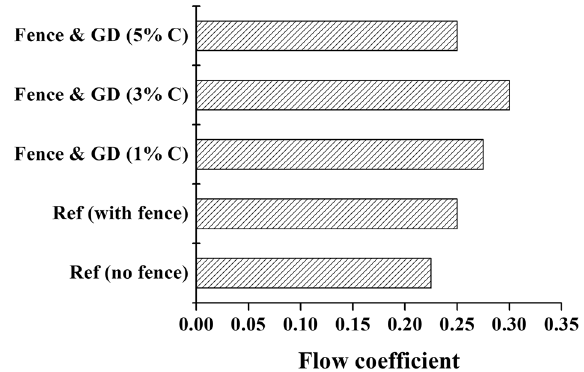
Figure 9. Comparison of stall points for different